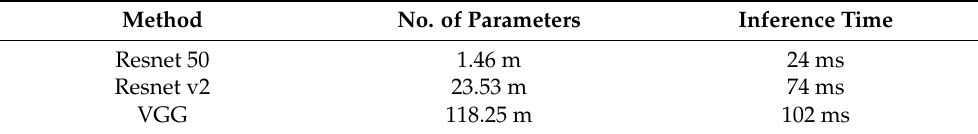
Table 1. Computational cost